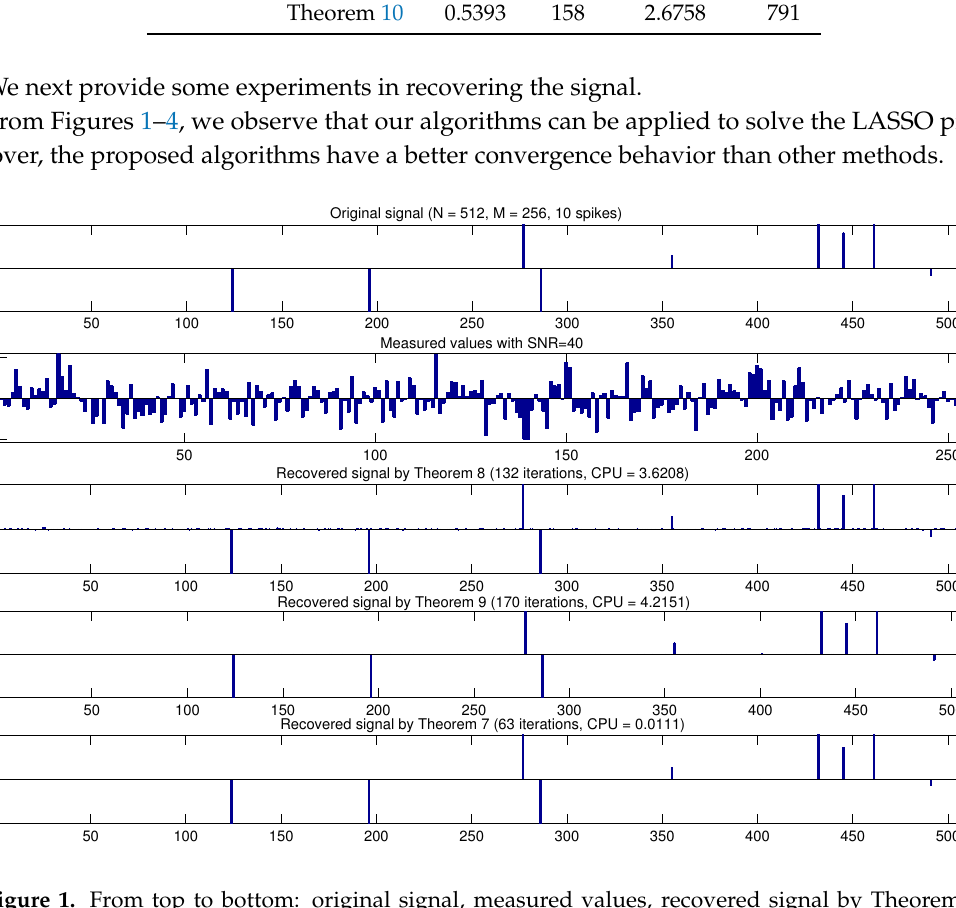
Figure 1. From top to bottom: original signal, measured values, recovered signal by Theorem 8, Theorem 9 and Theorem 7 with N = 512, M = 256 and m =